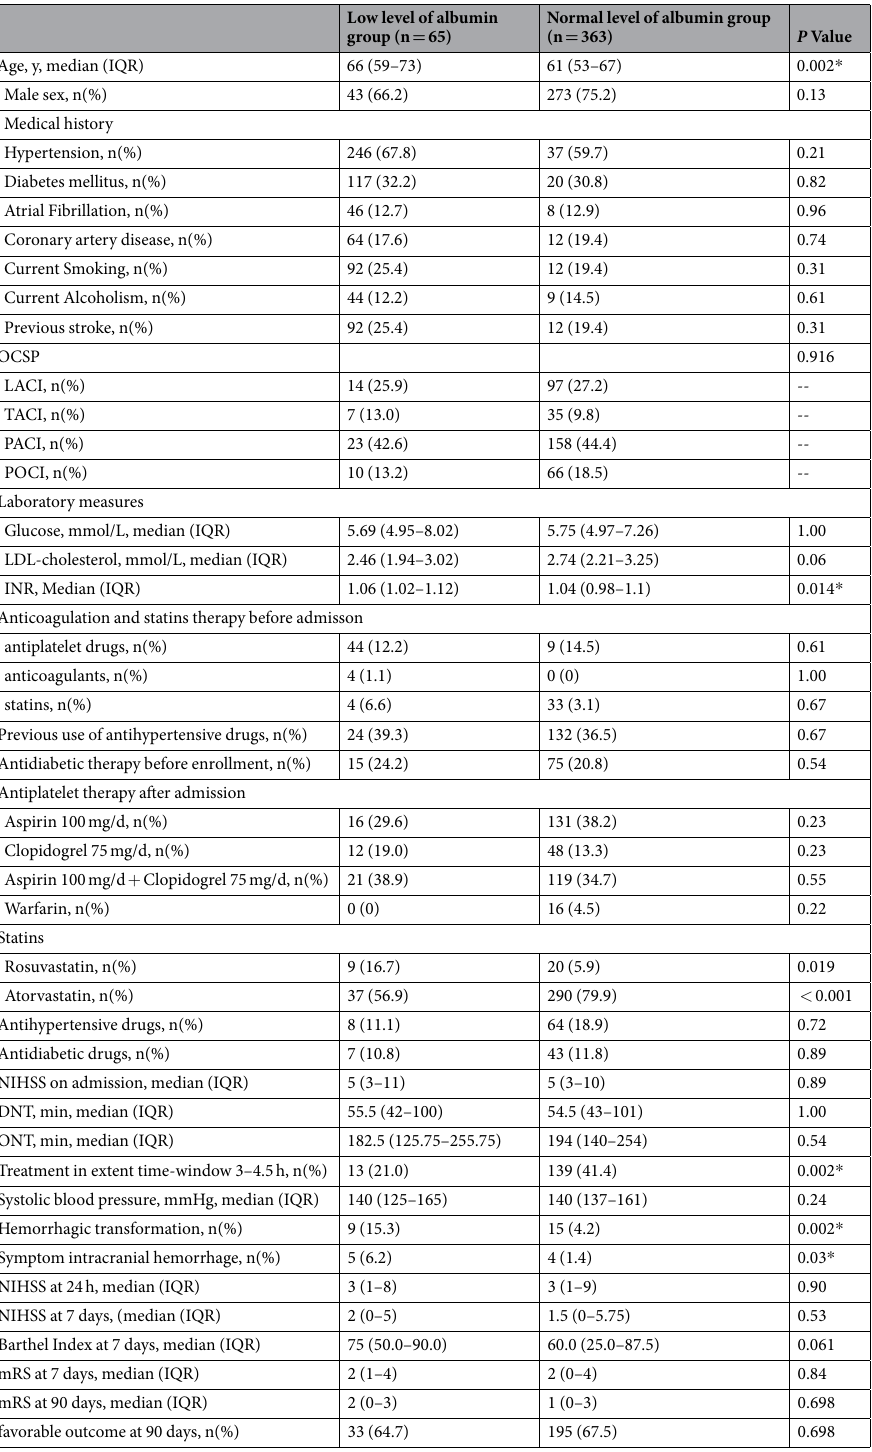
Table 1. Baseline Characteristics and Outcome Measures of Stroke Patients Receiving Different levels of Albumin in Serum. P < 0.05. NIHSS, National Institutes of Health Stroke Scale; ONT, onset to needle time; DNT, door to needle time; OCSP, Oxfordshire Community Stroke Project; LACI, lacunar infarct; TACI, total anterior circulation infarct; PACI, partial anterior circulation infarcts; POCI, posterior circulation infarcts; LDL, low-density lipoprotein; INR, international normalized